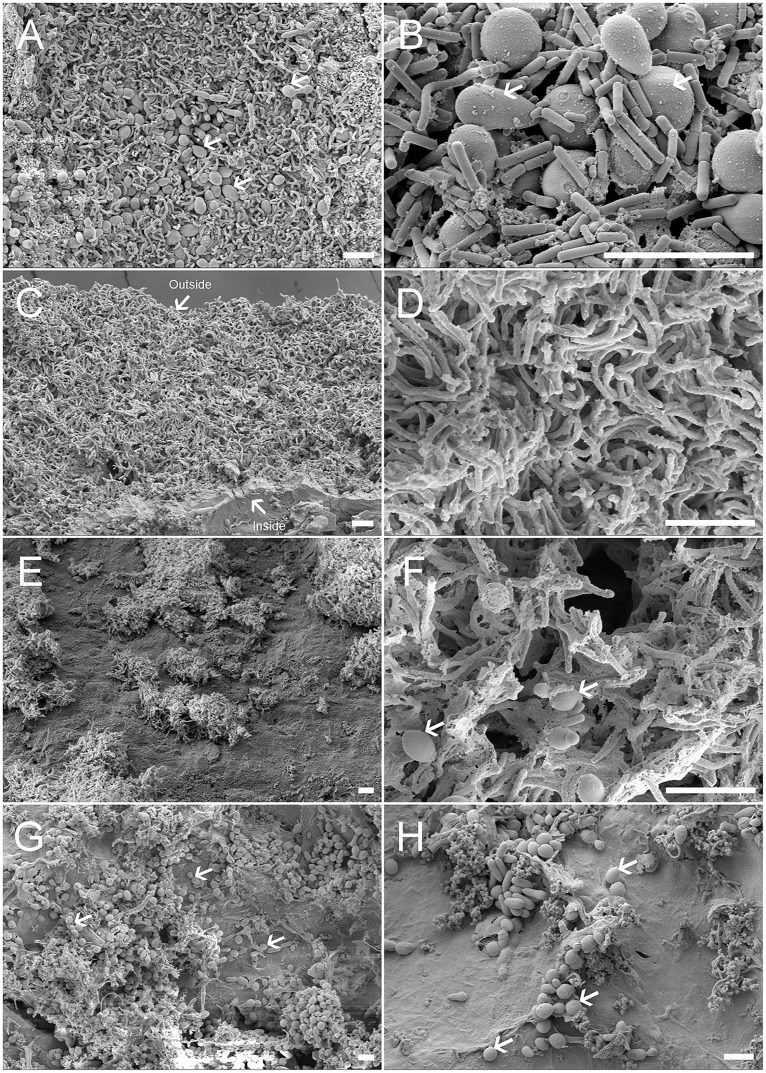
Scanning electron micrographs of TKGs.(A) The outer surface of TKGs; (B) The high magnification of (A); (C) The cross-section of TKGs; (D) The high magnification of (C); (E) The inner surface of NCTKGs; (F) The high magnification of (E); (G) The inner surface of ACTKGs; (H) The high magnification of (G). The arrows, shown in (A), (B), (F), (G), and (H), indicate the representative yeasts in KGs. The outside and inside surfaces of KGs are indicated by the arrows in (C). Scale bar = 10.0 µm.